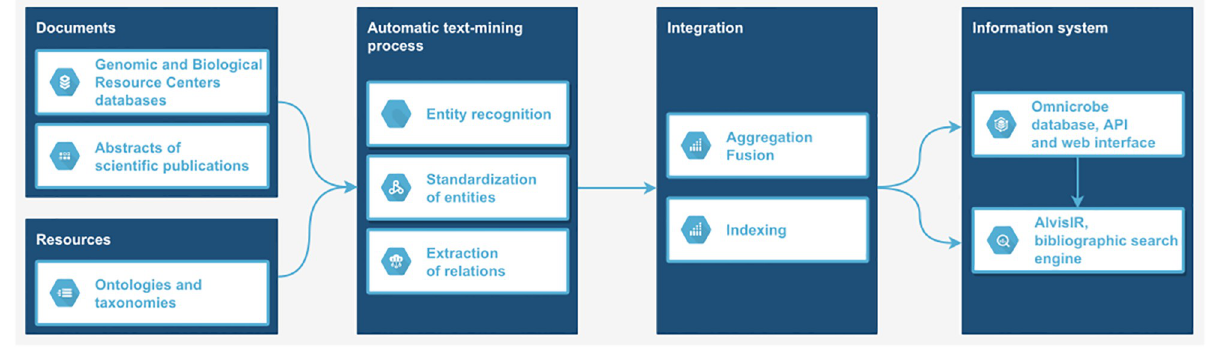
Fig 2. Information system